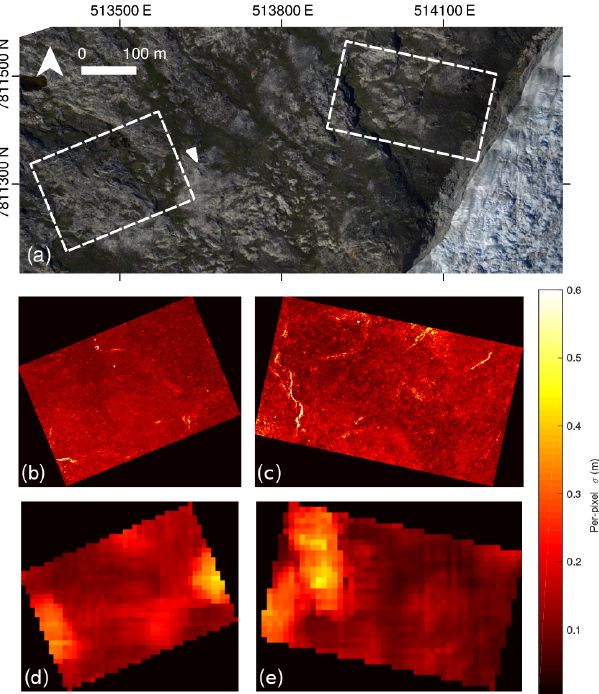
Figure 6. Error assessment at the calving front: (a) location of two validation sites at the calving front shown on UAV-derived or- thophoto, (b–c) standard deviation in the z axis derived from DEMs, and (d–e) standard deviation in the x and y axes derived from hori- zontal displacement